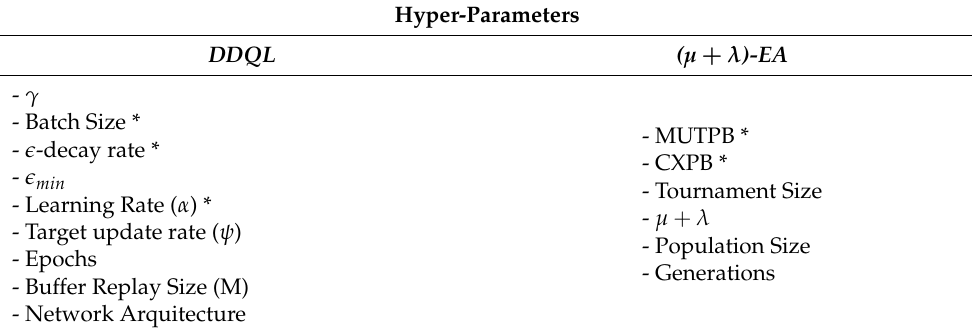
Table 3. Main hyper-parameters involved in both methods. With *, the most sensible hyper- parameters for each